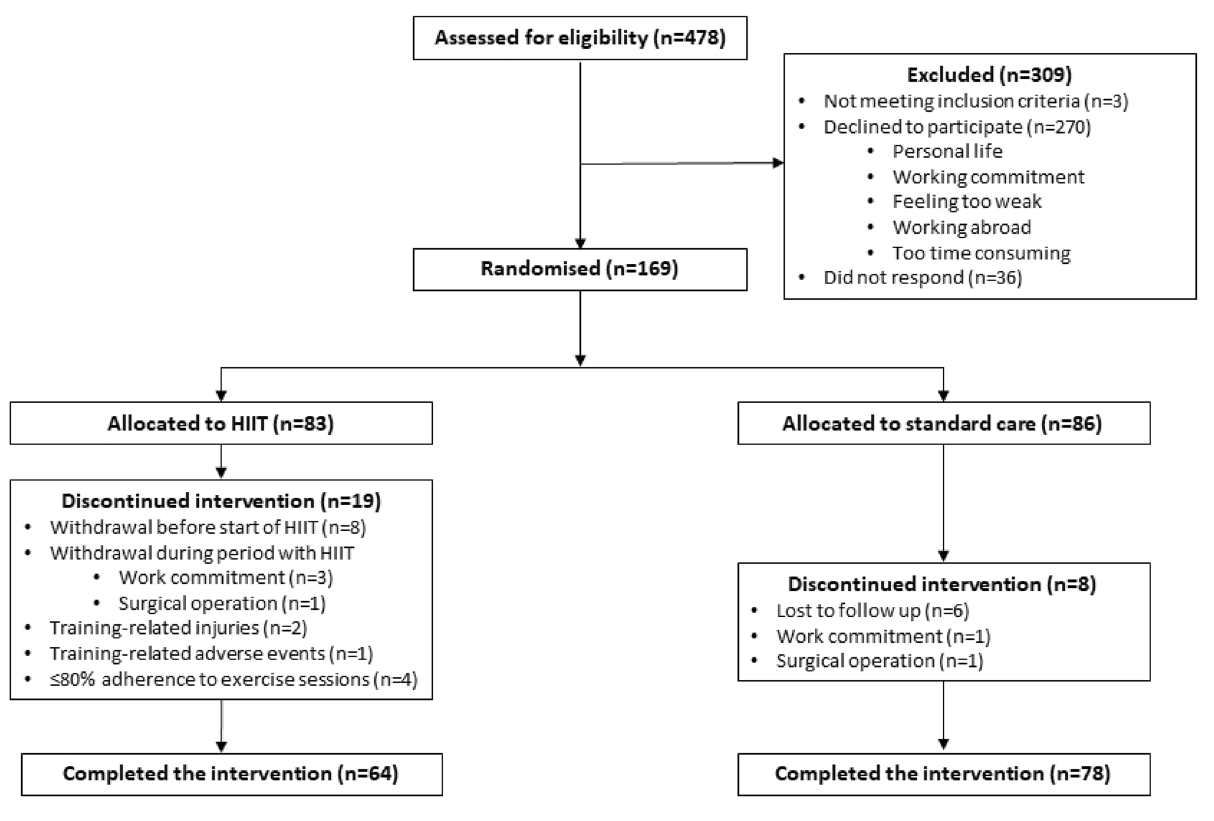
Figure 1. Flowchart of recruitment for the randomised controlled trial. HIIT high-intensity interval training.